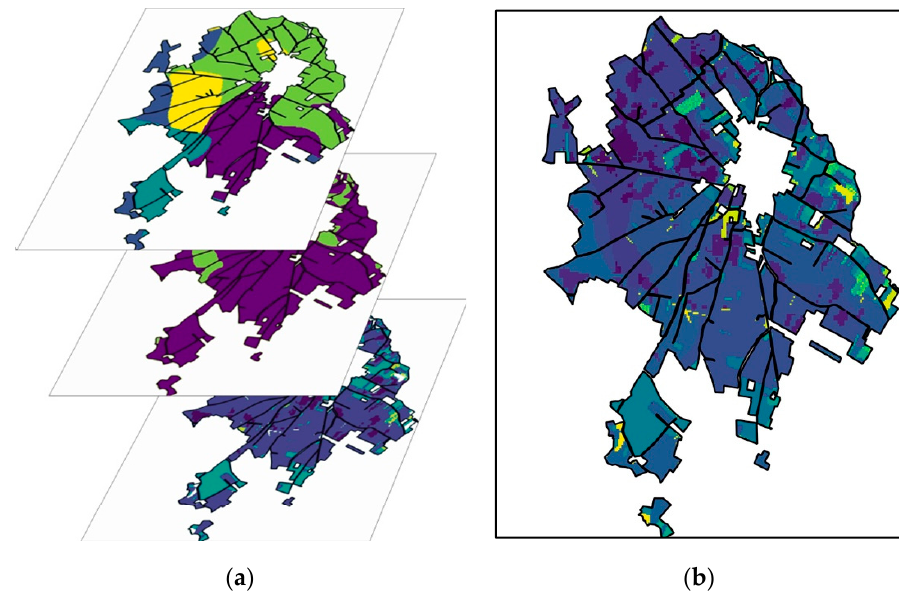
Figure 5. Maps obtained for the pilot district. ( a ) From the top: soil units, groundwater level zones, and land use and irrigation methods; ( b ) Homogeneous sub-units, where every colour represent one of the 50 homogeneous sub-units.